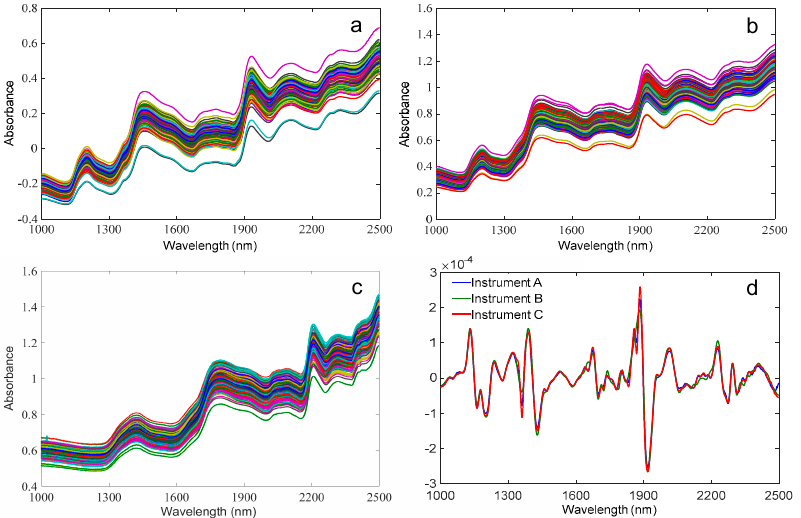
Figure 2. Spectra of forage maize collected from three different NIR spectrometers and their representative spectra of the second derivative (( a ) instrument A; ( b ) instrument B; ( c ) instrument C; ( d ) NIR average spectra (second derivative) of forage maize).